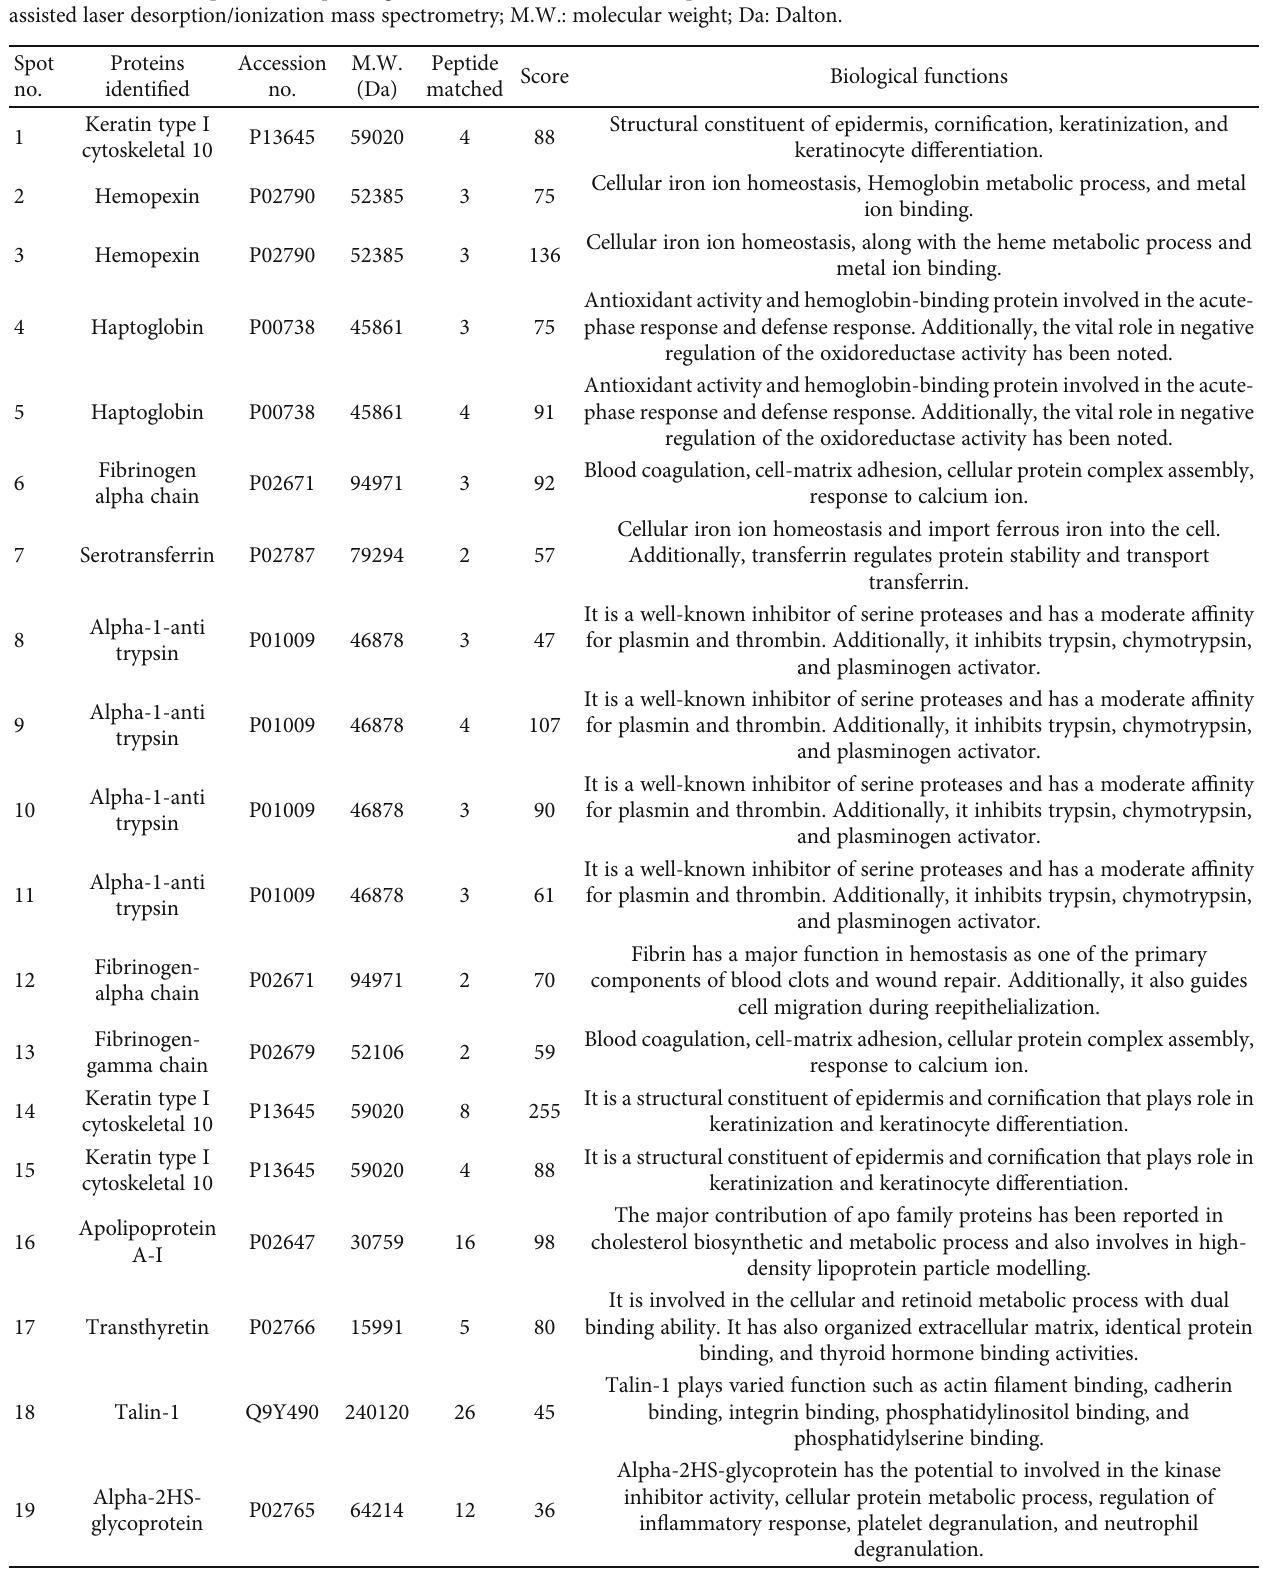
Table 2: List of identi fi ed proteins from MALDI-TOF MS/MS analyses, which are di ff erentially expressed in plasma of CAD patients with respect to healthy control. For statistical evaluation, p < 0 : 05 was used as a signi fi cance threshold during the Mascot search database and uniProt database (http://www.uniprot.org/) that were searched for the protein function. Annotation: MALDI-TOF MS/MS: matrix- assisted laser desorption/ionization mass spectrometry; M.W.: molecular weight; Da: